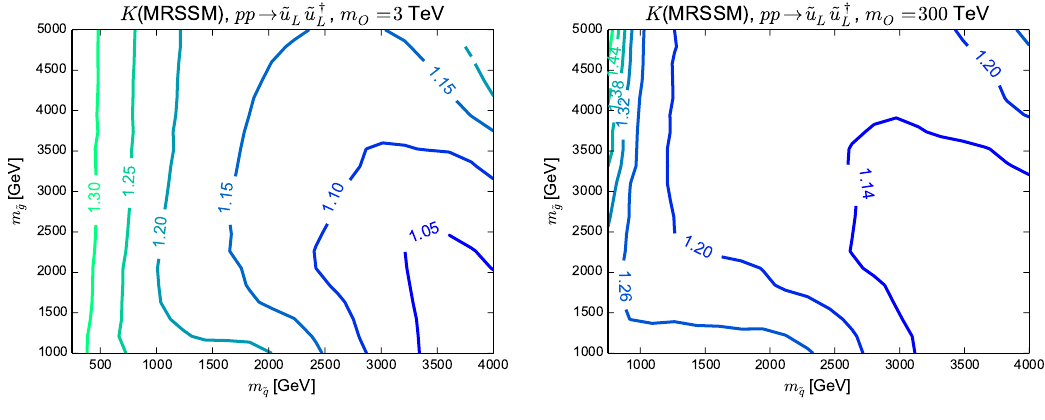
Figure 12. As (cid:12)gure 11 for ~ u L ~ u y